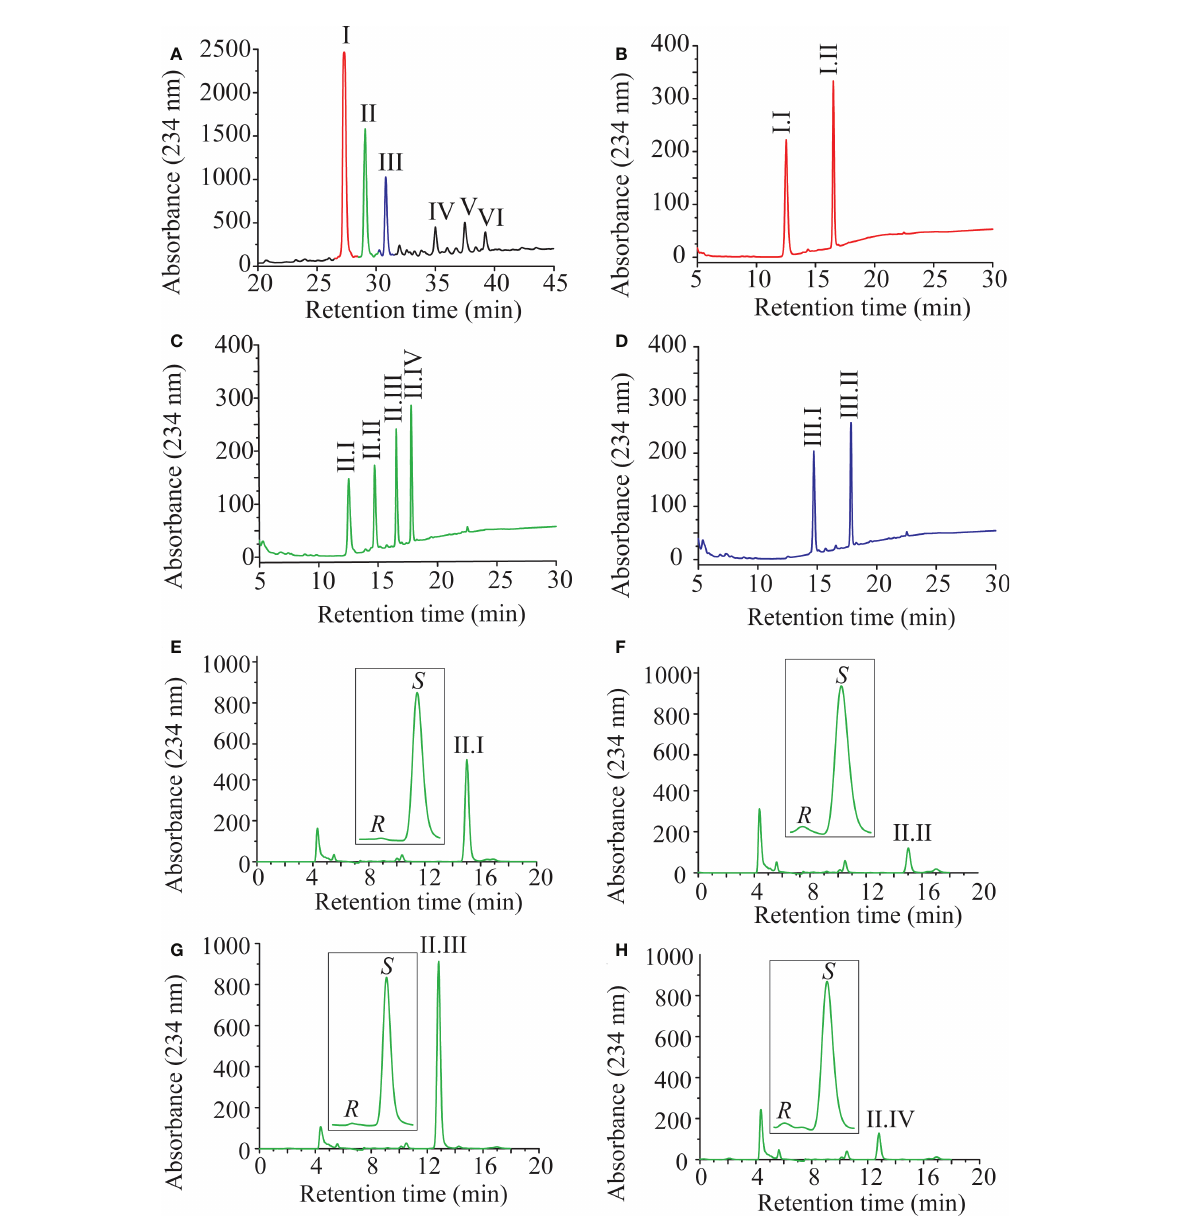
FIGURE 6 Sequential HPLC analysis of oxidation products of LiLOX with MGDG isolated from L. incisa . (A) Puri fi cation of the oxidized MGDG products by RP HPLC (same Figure as in 5A). (B-D) After transmethylation of the acyl chains from the peaks I; II and III, the mixtures of oxidized fatty acid methyl esters were puri fi ed one more time by RP HPLC. (B) Peak I. (C) Peak II. (D) Peak III. (E-H) Sequential analysis of the oxidized fatty acid methyl esters from the peak II by SP HPLC and CP HPLC. (E) Peak II.I: 11 S -HHTE. (F) Peak II.II: 11 S -HHDE. (G) Peak II.III: 13 S -HOTE. (H) Peak II.IV: 13 S -HODE. The identity of the methyl-esters was con fi rmed by authentic standards. RP-HPLC and SP-HPLC chromatograms are representative of at least three measurements with independent enzyme preparations. CP-HPLC chromatograms are representative of